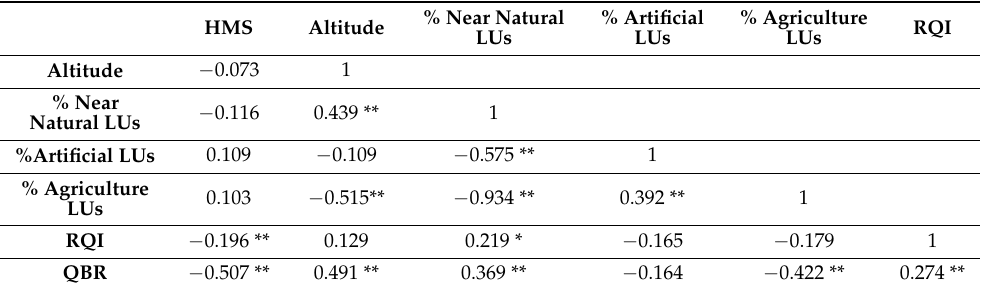
% Artificial % Agriculture RQI LUs LUs LUs